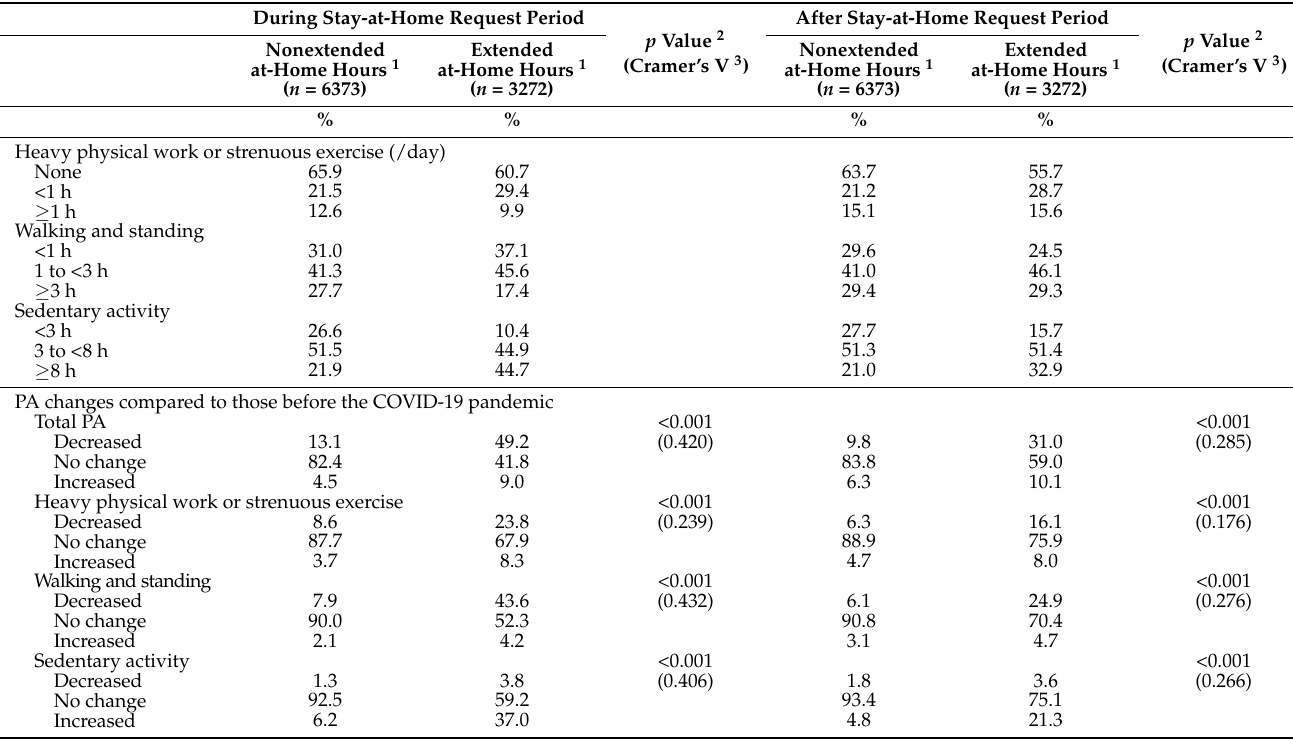
Table 2. Physical activity (PA) during and after stay-at-home request period according to changes in at-home hours during stay-at-home request.